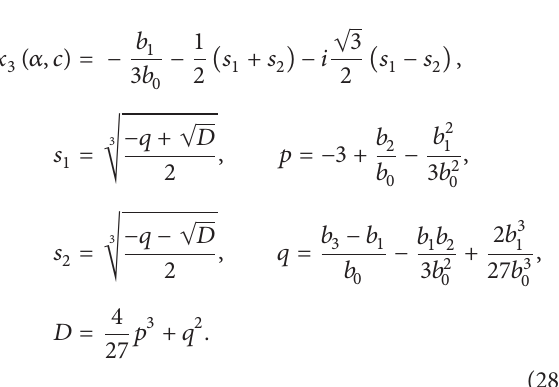
Figure 3: Bifurcation diagram of fixed points for 𝛼 = −1 . 𝑏 = −3 + 3𝛼 + 0